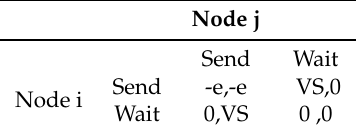
Table 2. Predigest game benefit of two nodes contend